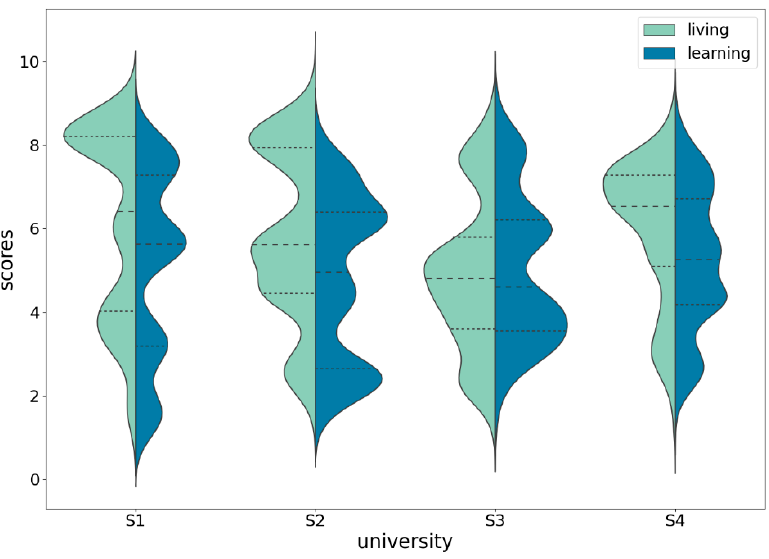
Figure 1. Violin plot of data from 4 universities.